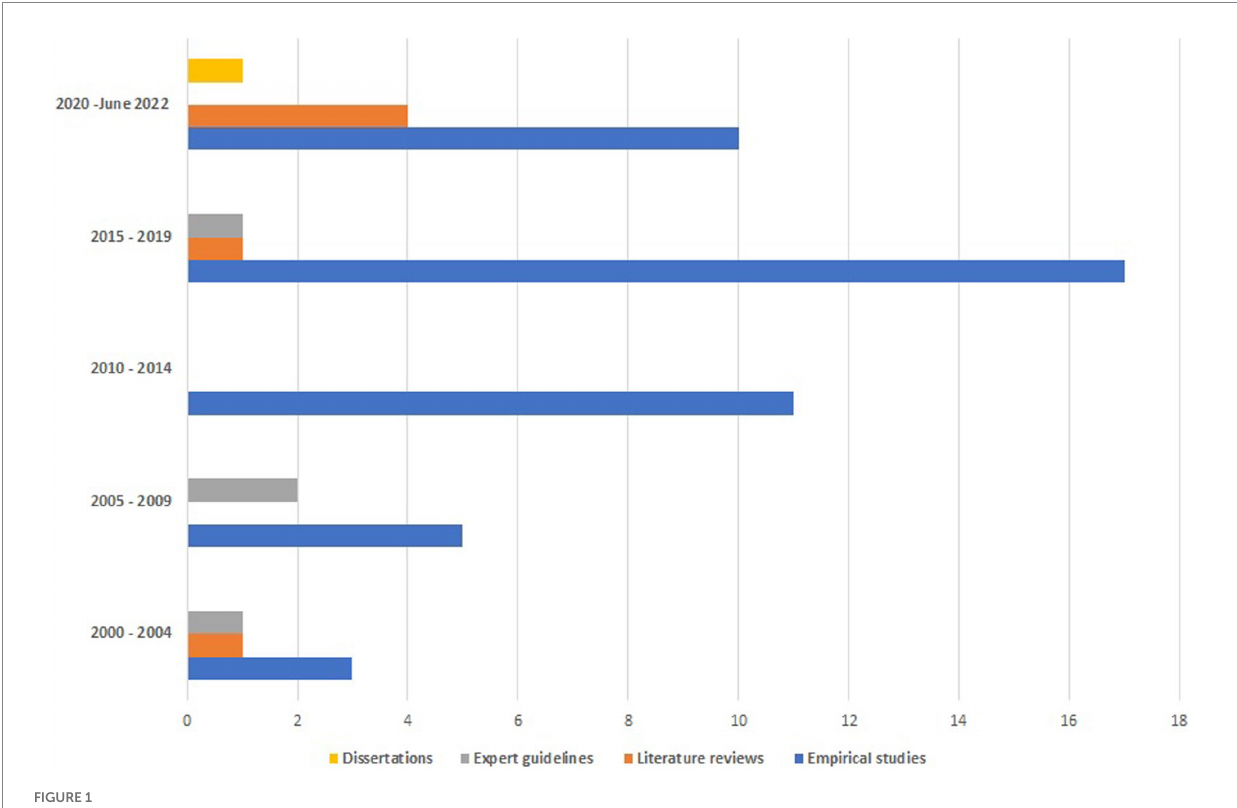
FIGURE 1 Number of items included per 5-year publication